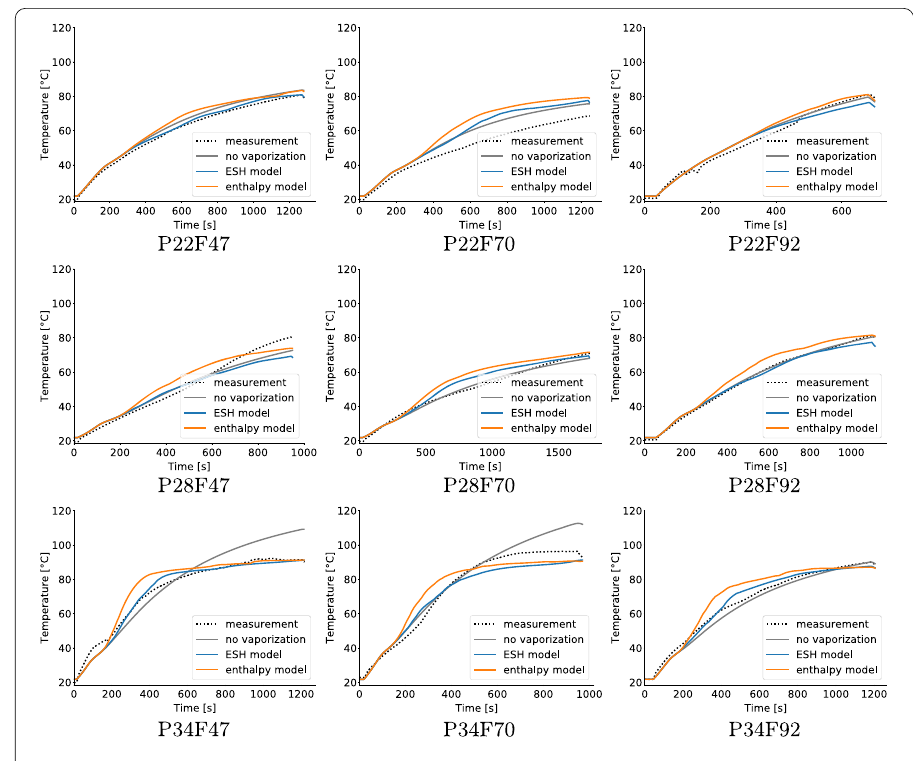
Figure 5 Comparison of the models with temperature measurements